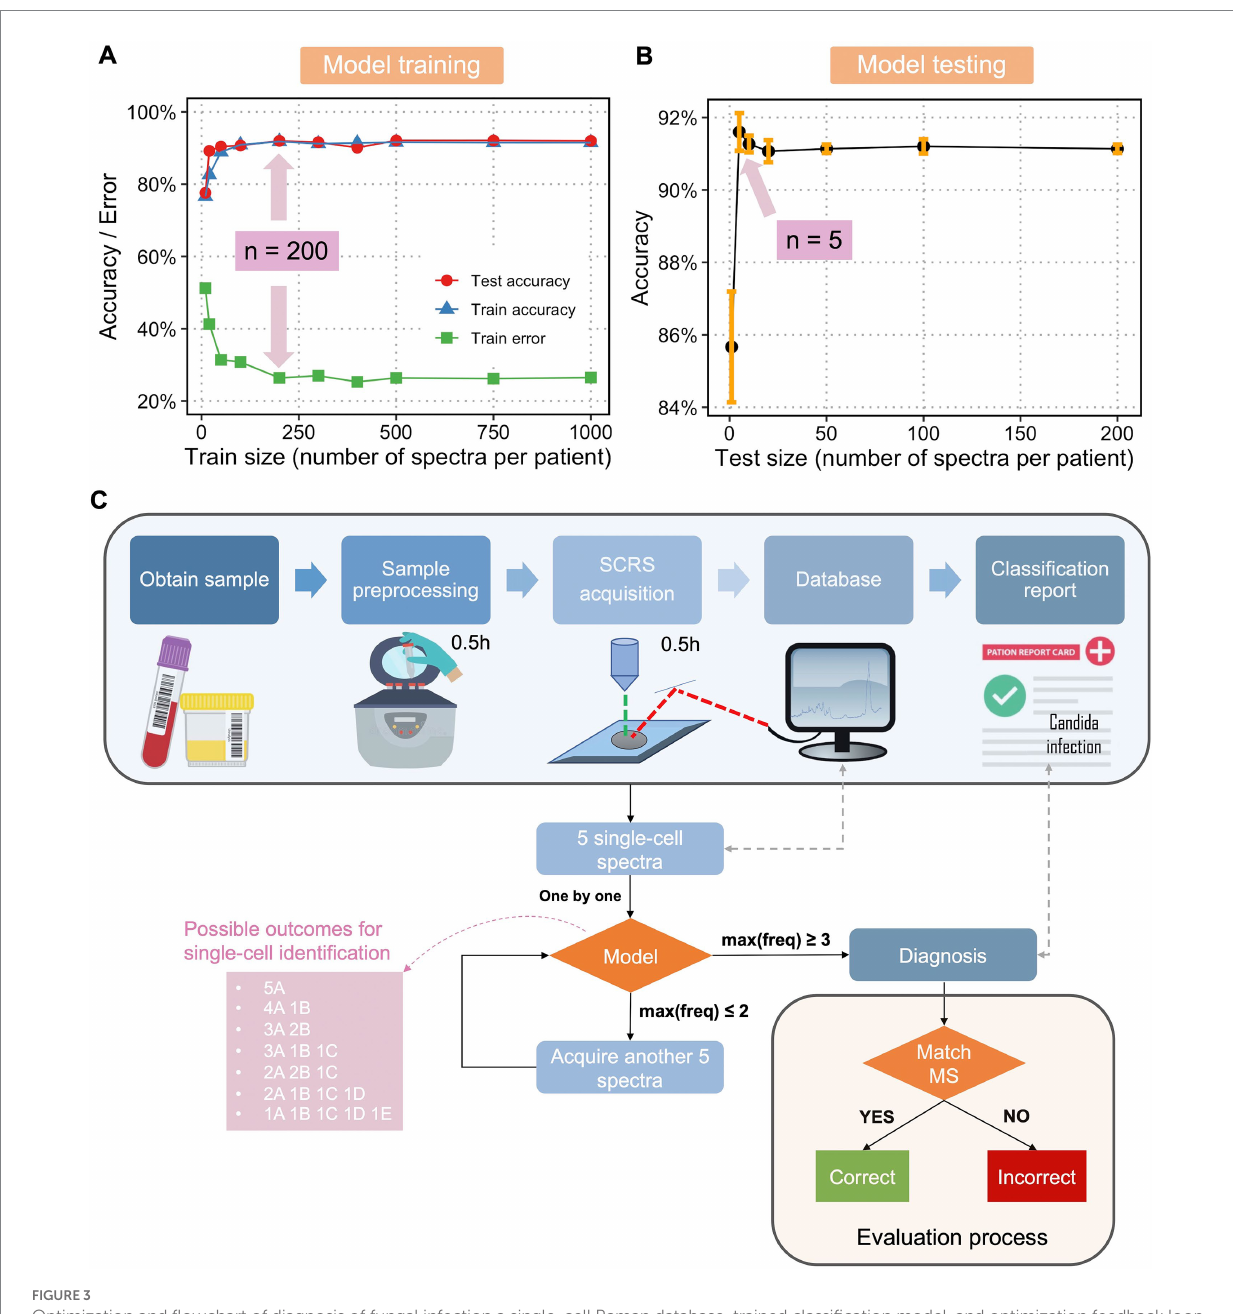
FIGURE 3 Optimization and flowchart of diagnosis of fungal infection a single-cell Raman database, trained classification model, and optimization feedback loop. (A) Train size versus train accuracy, train error, and test accuracy and (B) test size versus test accuracy using single-cell Raman spectra of fungi and an LDA classification model. Sample size at the highest accuracy and/or lowest error was labelled. (C) Flowchart of a Raman-based diagnosis of clinical fungal infections. The pink box shows the seven possible outcomes for single-cell identification using 5 spectra per sample, with A, B, C, D, and E as hypothetical fungal species. Only when the maximum frequency of one class, max(freq) ≥ 3 (the first four scenarios in the pink box), a final diagnosis will be given. When the max(freq) < 3 (the last three scenarios in the pink box), another 5 spectra will be acquired. The process continues until max(freq) reaches 3 or more. The final diagnosis is compared with results from MALDI-ToF MS to evaluate the performance of the model and optimization